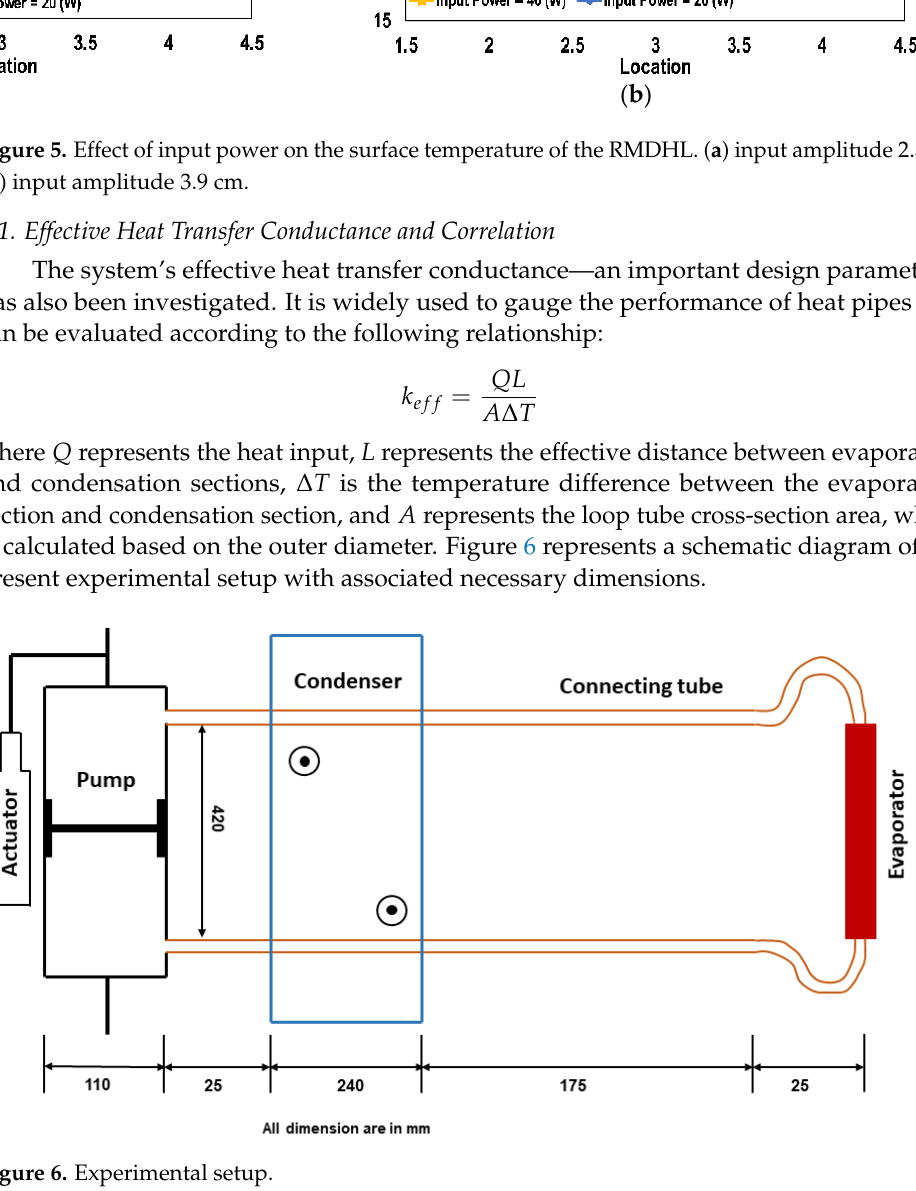
Figure 5. Effect of input power on the surface temperature of the RMDHL. ( a ) input amplitude 2.5 cm ( b ) input amplitude 3.9 cm.